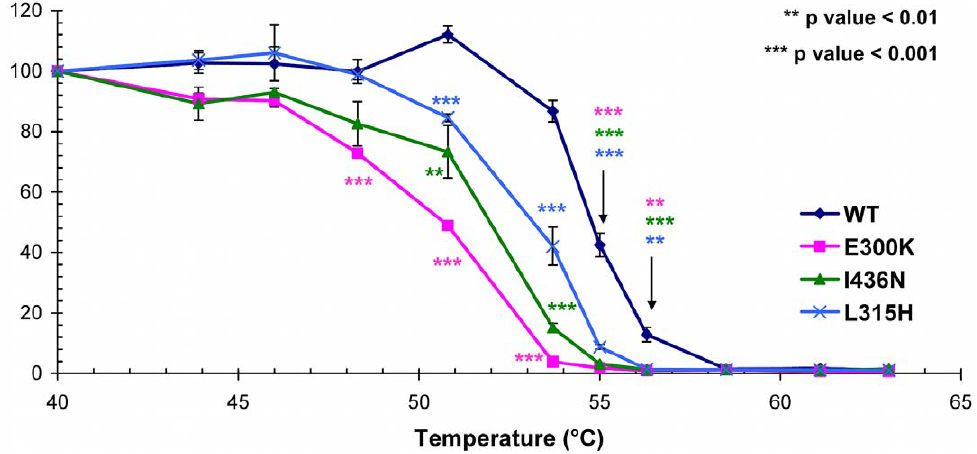
Figure 2. Assessment of thermostability for GCK-GST mutant proteins. Proteins were incubated for 30 minutes over a range of temperatures (40–60 u C). Given data are means 6 SEM, and were obtained from 6 independent measurements. The previously reported thermal instability mutant E300K [31](pink) was used as a positive control. The level of significance at each temperature point (mutants versus wild-type GCK activity) was calculated using an independent t-test.